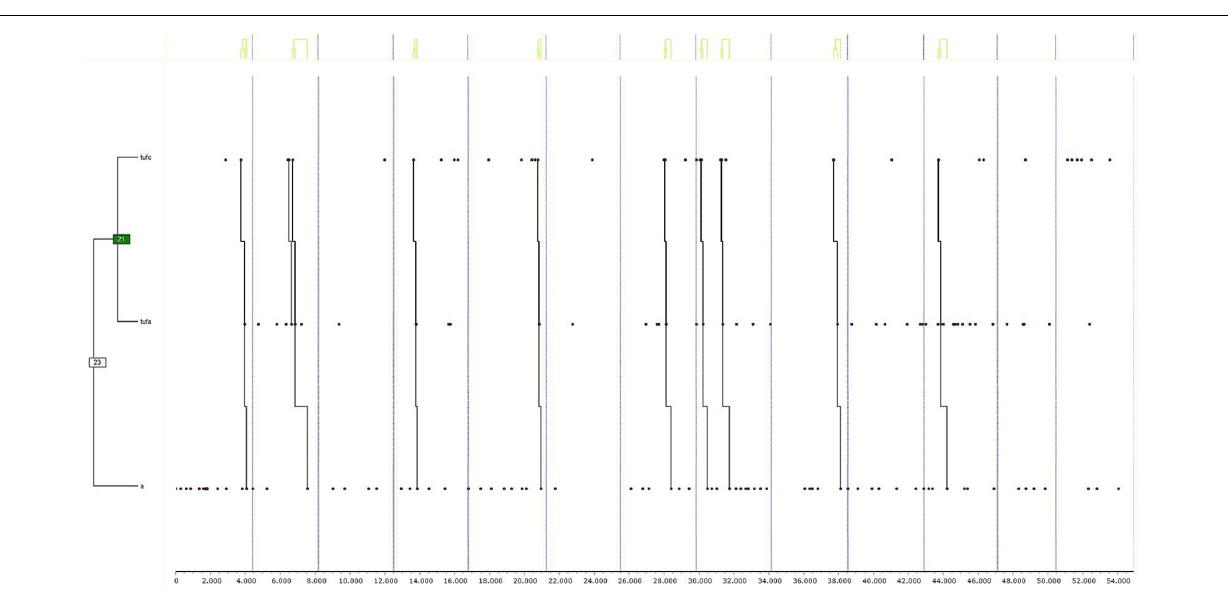
FIGURE 5 | Dendogram obtained from THEME belonging to group “2” exclusively in boys. The decisional categories of the mixed registration system ( Table 1 ) were used for searching for